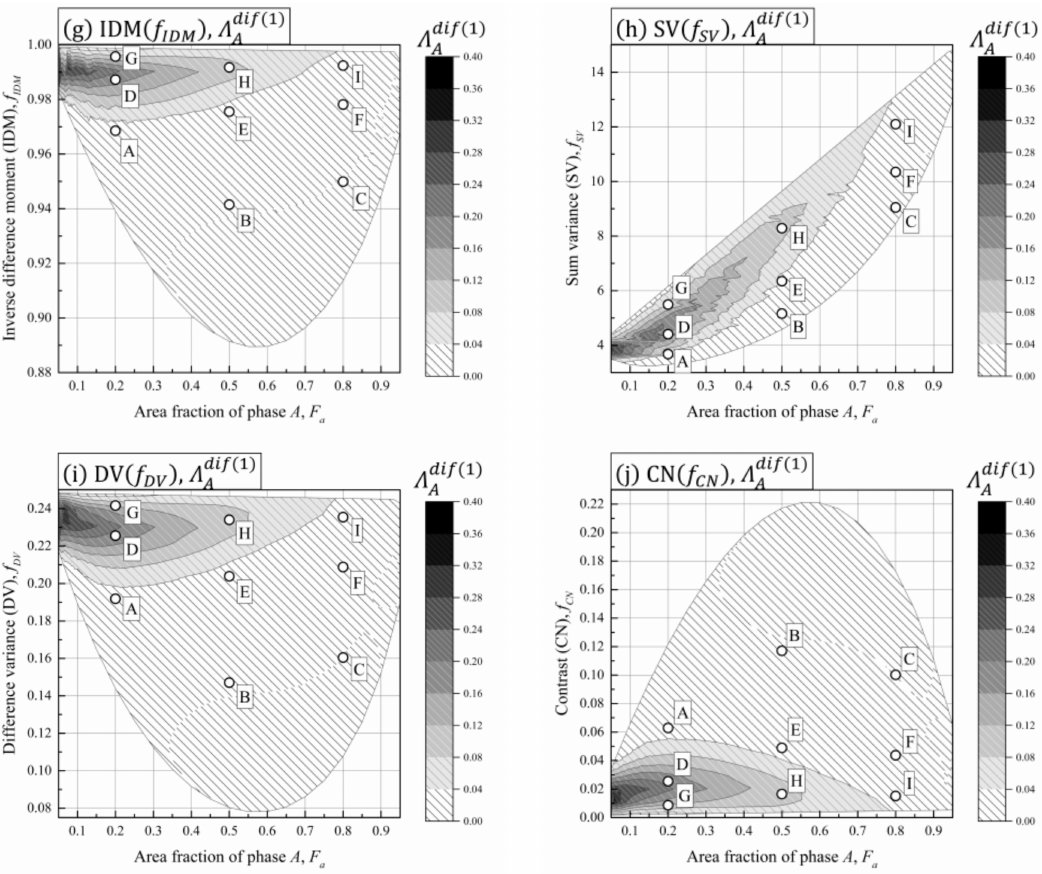
Figure 7. Isograms showing the difference between the 2D and 3D composition distributions ( Λ dif obtained for Boolean structured spherical particle systems, with respect to various texture characteristics ( f ) and the phase A areal fraction ( F a ). ( a – d ) compare the Λ dif ( f EN ); ( e – j ) respectively show the Λ dif